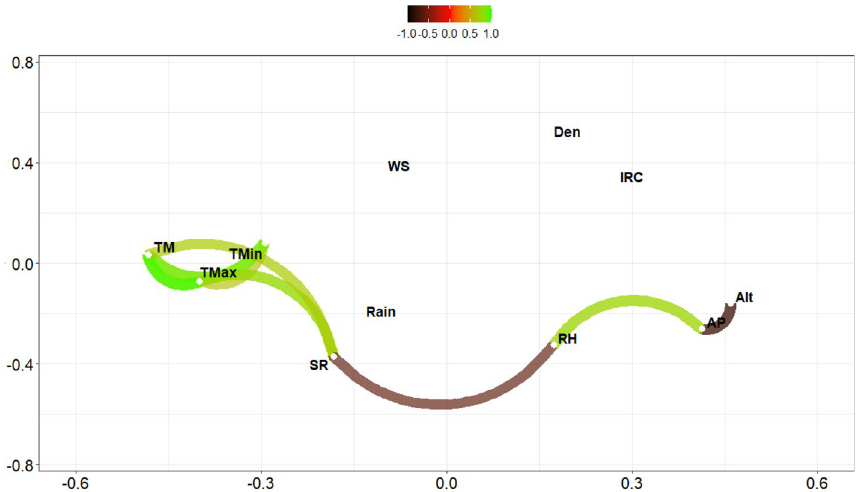
Figure 1. Correlations plot of environmental database COVID-19. Green paths indicate positive correlations, brown paths negative correlations. TM= Average atmospheric temperature; TMax = Maximum atmospheric temperature; TMin = Minimum atmospheric temperature; RH = Relative humidity; Rain = Accumulated precipitation; AP = Atmospheric pressure; SR = Ultraviolet solar radiation; WS = Wind speed; Alt = Elevation; Den = Population density; IRC = Infection rate.